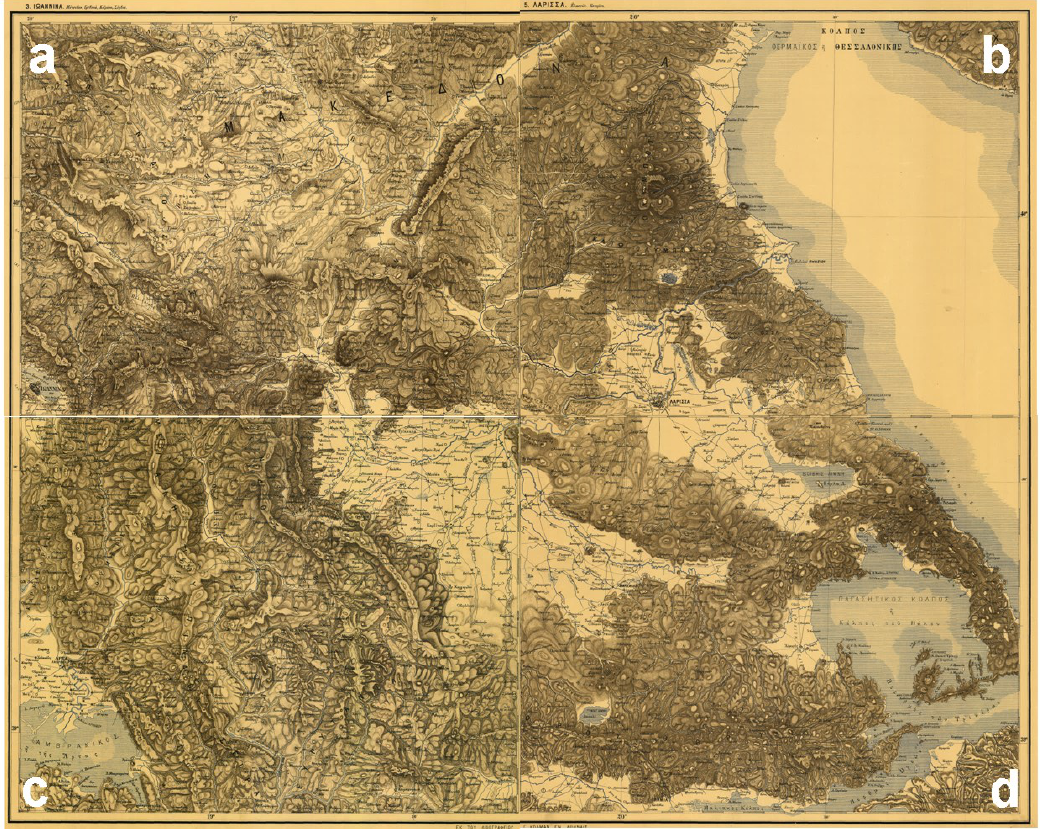
Figure 2. Old topographic maps of 1881, sheets: ( a ) Ioannina-Metsovon-Grevena-Kozani-Servia; ( b ) Larissa-Elasson-Katerini; ( c ) Arta-Trikala-Karditsa; ( d )